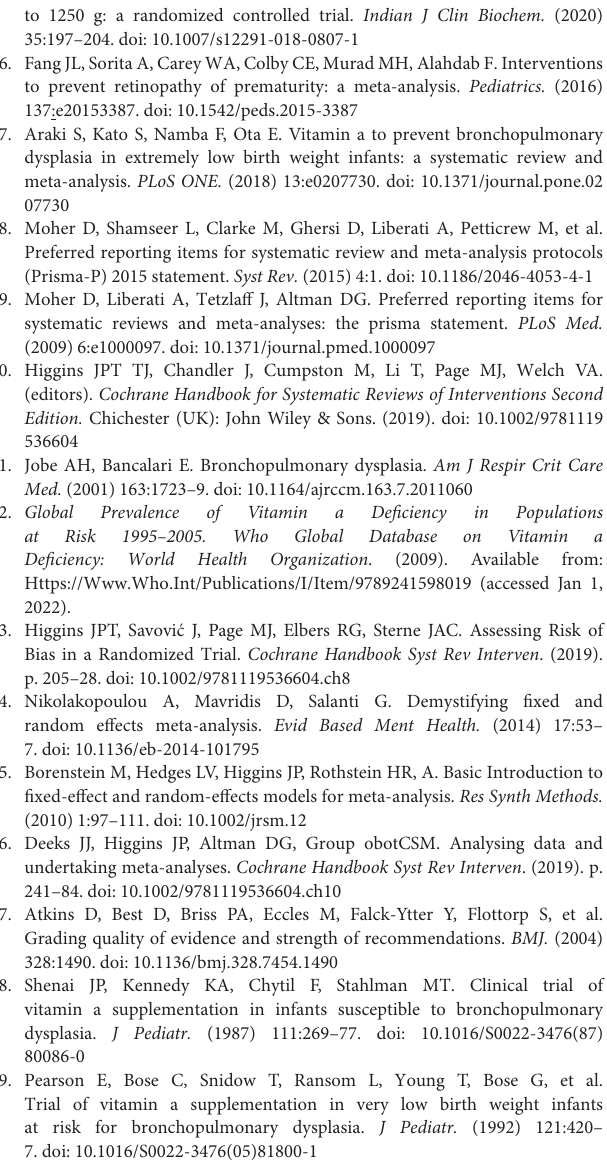
Supplementary Figure 1 | Effective vitamin A supplementation for prevention of BPD and mortality. (A) The forest plot for the incidence of oxygen dependency for 28 days among survivors. (B) The forest plot for the incidence of oxygen dependency at 36 weeks’ PMA among survivors. (C) The forest plot for the incidence of death before 1 month. (D) The forest plot for the incidence of death at 36 weeks’ PMA. Supplementary Figure 2 | The forest plot for the length of hospital stay. Supplementary Figure 3 | (A) The forest plot for the plasma retinol. (B) The forest plot for the incidences of vitamin A deficiency.